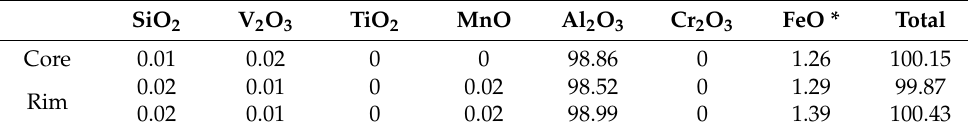
Table 1. Major Chemical composition of the host (EPMA).